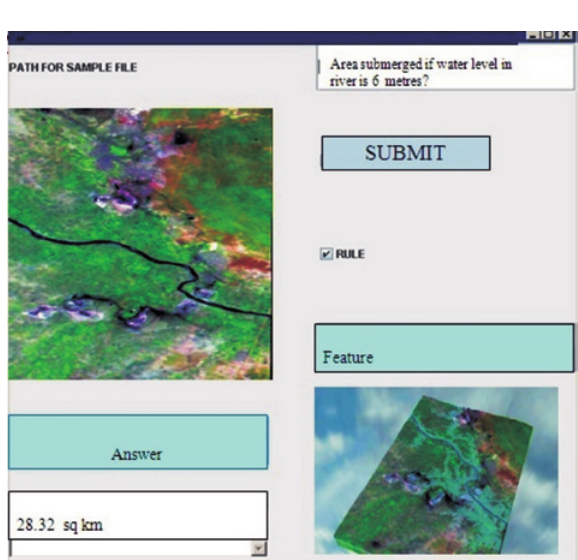
Fig. 5. Description queries